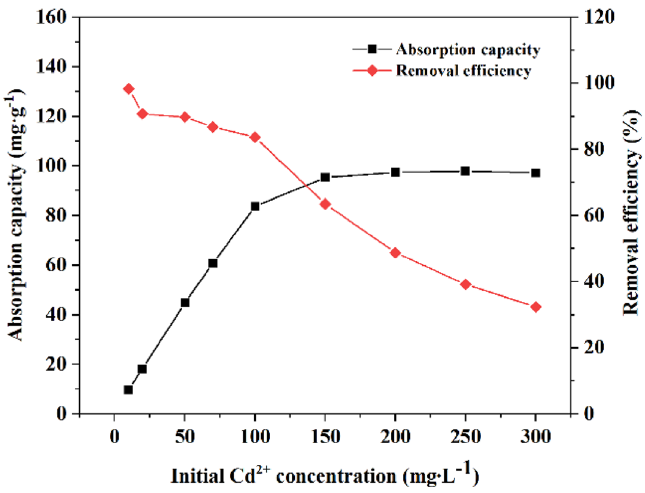
Figure 12. Effect of the initial Cd 2+ concentration on the adsorption of Cd 2+ on MRM at pH = 6, T = 25 °C, t = 240 min and dosage = 1 g L −1 .